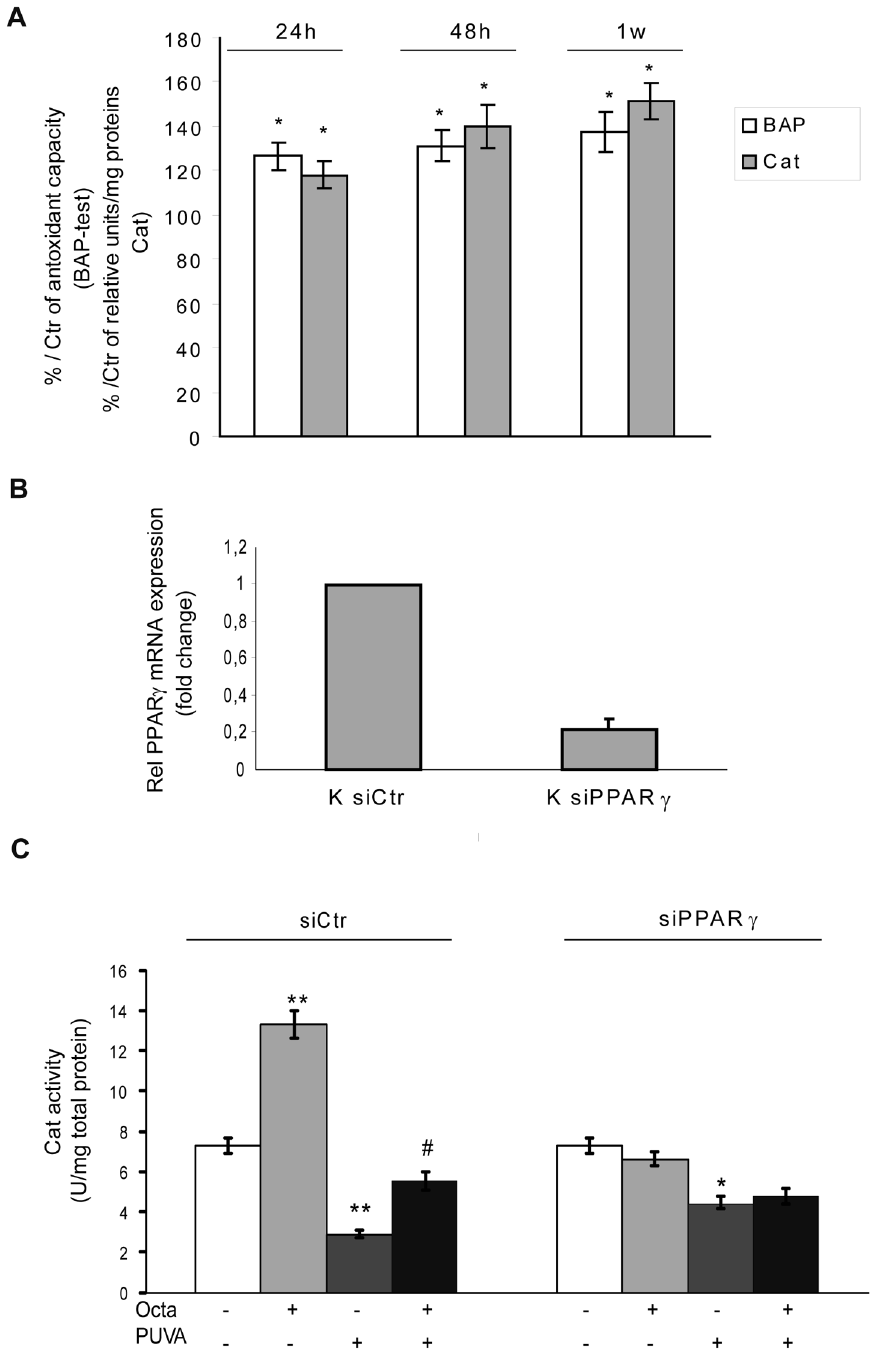
Figure 5. Evidence for PPAR c -induced promotion of cell antioxidant defence. (A) Octa treatment for 24 h, 48 h and 1 week determined a significant increase of antioxidant cell response. TAC was assessed by BAP-test and Cat enzyme activity was determined by spectrophotometry as described under Materials and Methods section. (B) HDFs were transfected with siRNA specific for PPAR c (siPPAR c ) or non-specific siRNA (siCtr). PPAR c level was evaluated by real-time RT-PCR (C) The activity of Cat was assessed in HDFs transfected with siPPAR c or siCtr and exposed to 2 m M Octa for 6 h. In parallel Cat activity was measured in HDFs transfected with siPPAR c or siCtr and exposed to PUVA w/o post-incubation with 2 m M Octa. *p , 0.05; **p , 0.001 respect to control fibroblasts; # p , 0.05 compared with PUVA-treated fibroblasts.